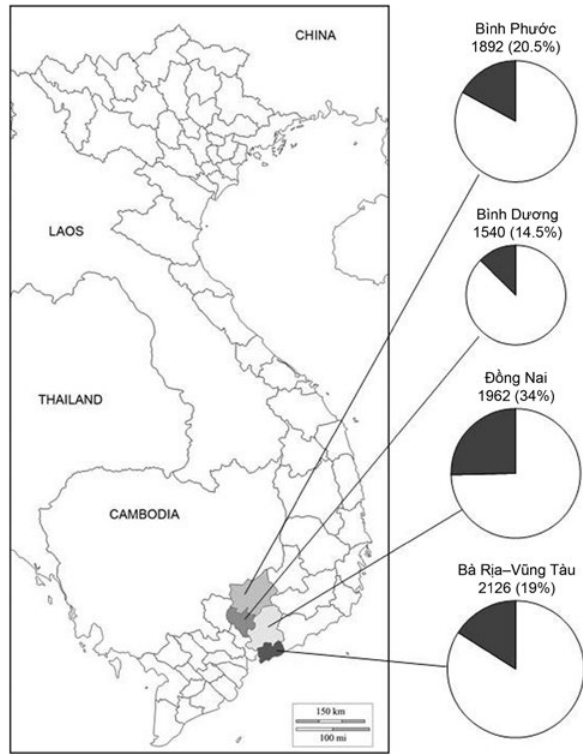
Figure 1. Diagrammatic representation of the incidence of the decline incited by Phytophthora palmivora in jackfruit plantings in four provinces of South Vietnam; the size of pies is proportional to the number of surveyed trees in each province. Figures above pies indicate the total number of jackfruit trees surveyed and the proportion (within brack- ets) of symptomatic trees in each province, respectively. Note that this is not a map of Vietnam, but only the indica - tion of the provinces where the survey was carried out.